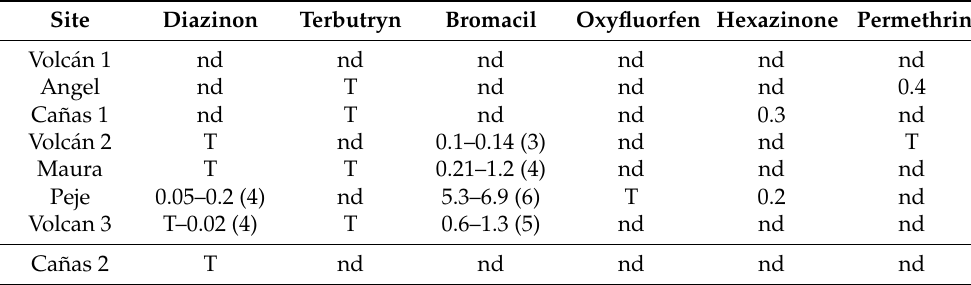
Table 4. Pesticide residues detected in the Volc á n River watershed (2011–2013). Concentrations ( µ g/L) are presented as min–max (no. detections). Where no interval and parenthesis are presented, only one detection was